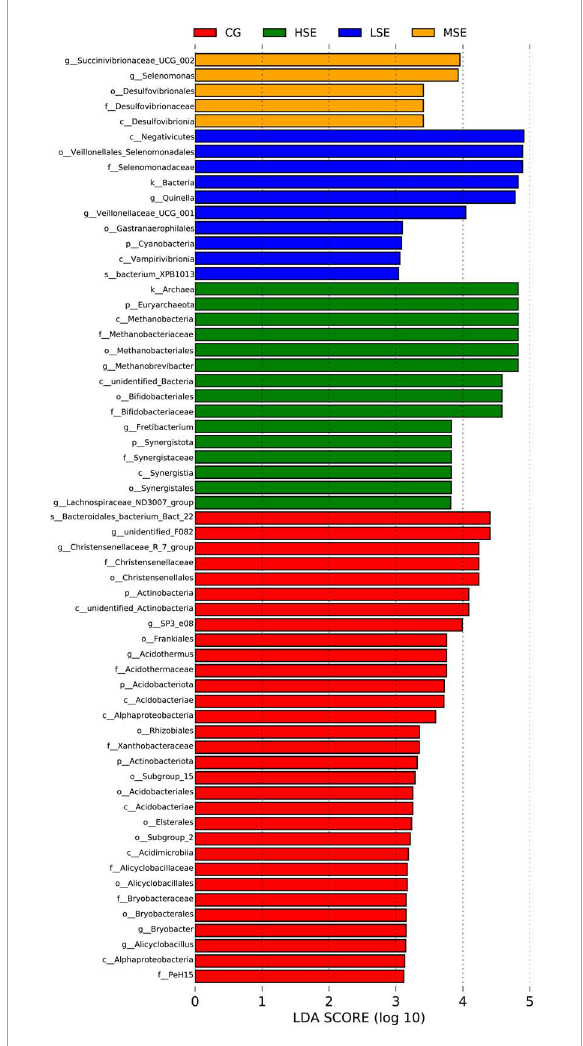
FIGURE5 Histogram of the LDA scores computed for differentially abundant rumen bacteria across four treatment groups. Linear discriminant analysis effect size scores could be interpreted as the degree of difference in relative abundance of the analyzed rumen bacteria communities across four groups. The histogram thus identifies which clades among all those detected as statistically and biologically differentially abundant and could explain the features most likely to explain differences across the